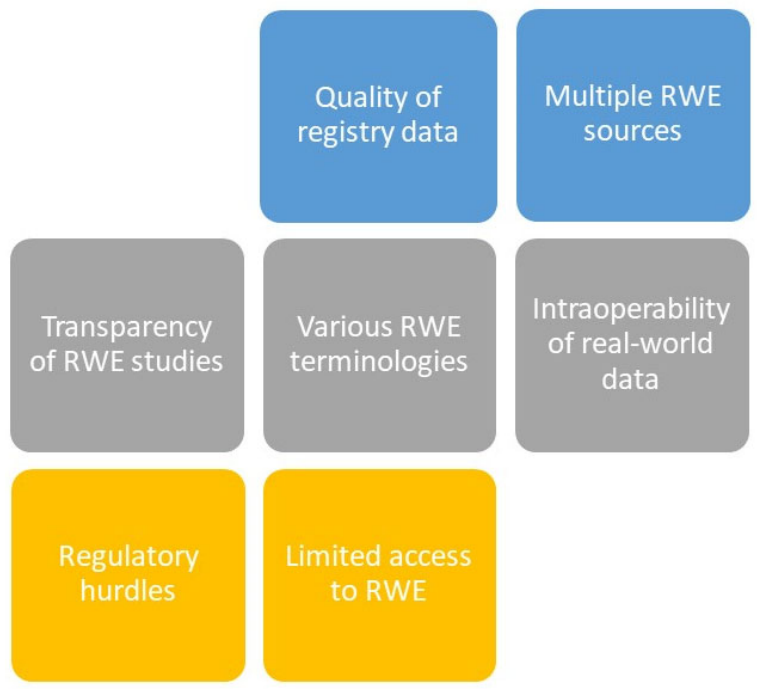
Figure 2. Challenges in RWE